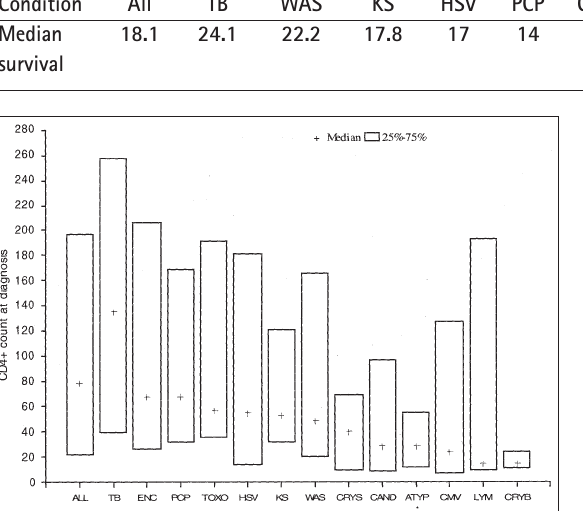
Fig. 2. CD4 count distribution at (or ± 6 months of) the date of